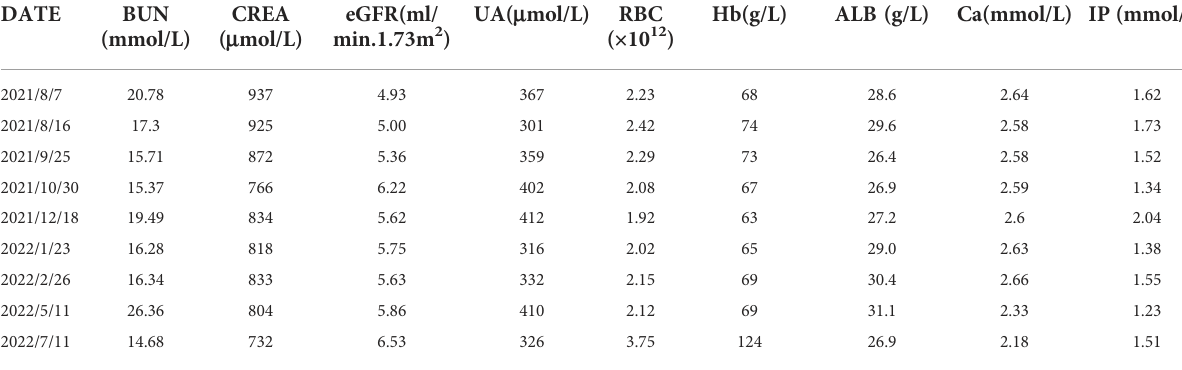
TABLE 1 Detection indicators of peripheral blood of